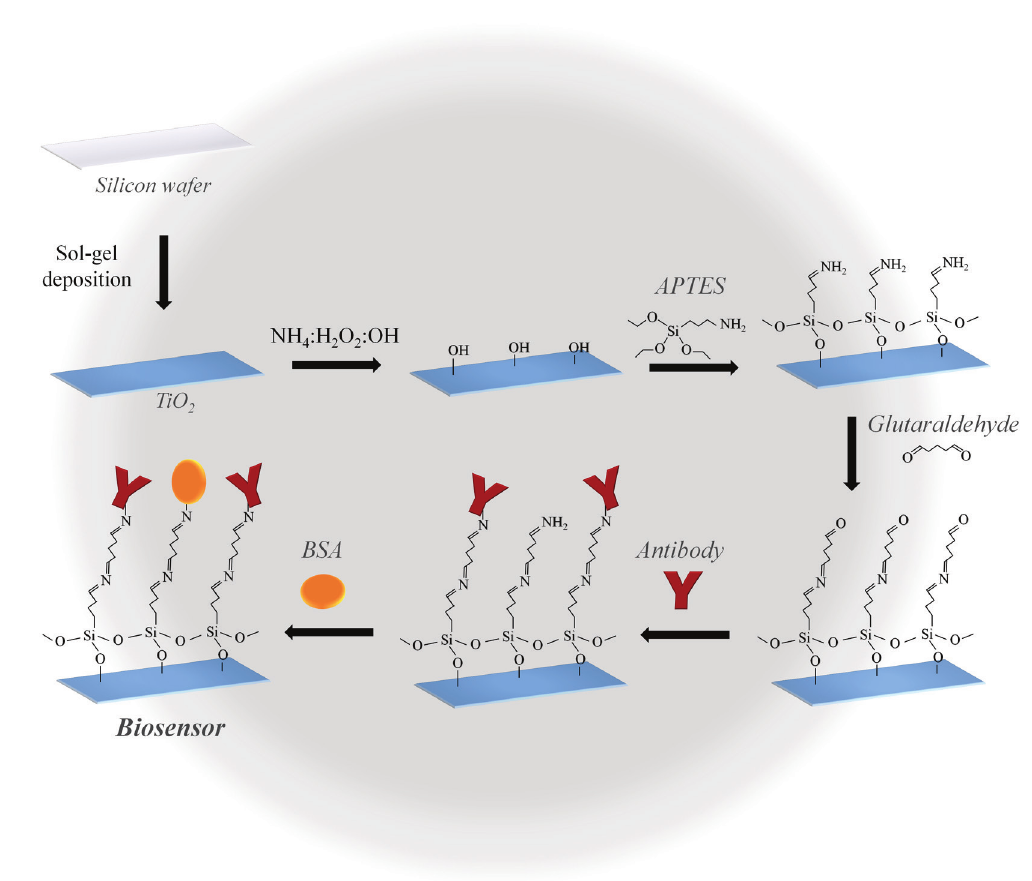
Fig. 1 – Schematic representation of the steps in obtaining the TiO